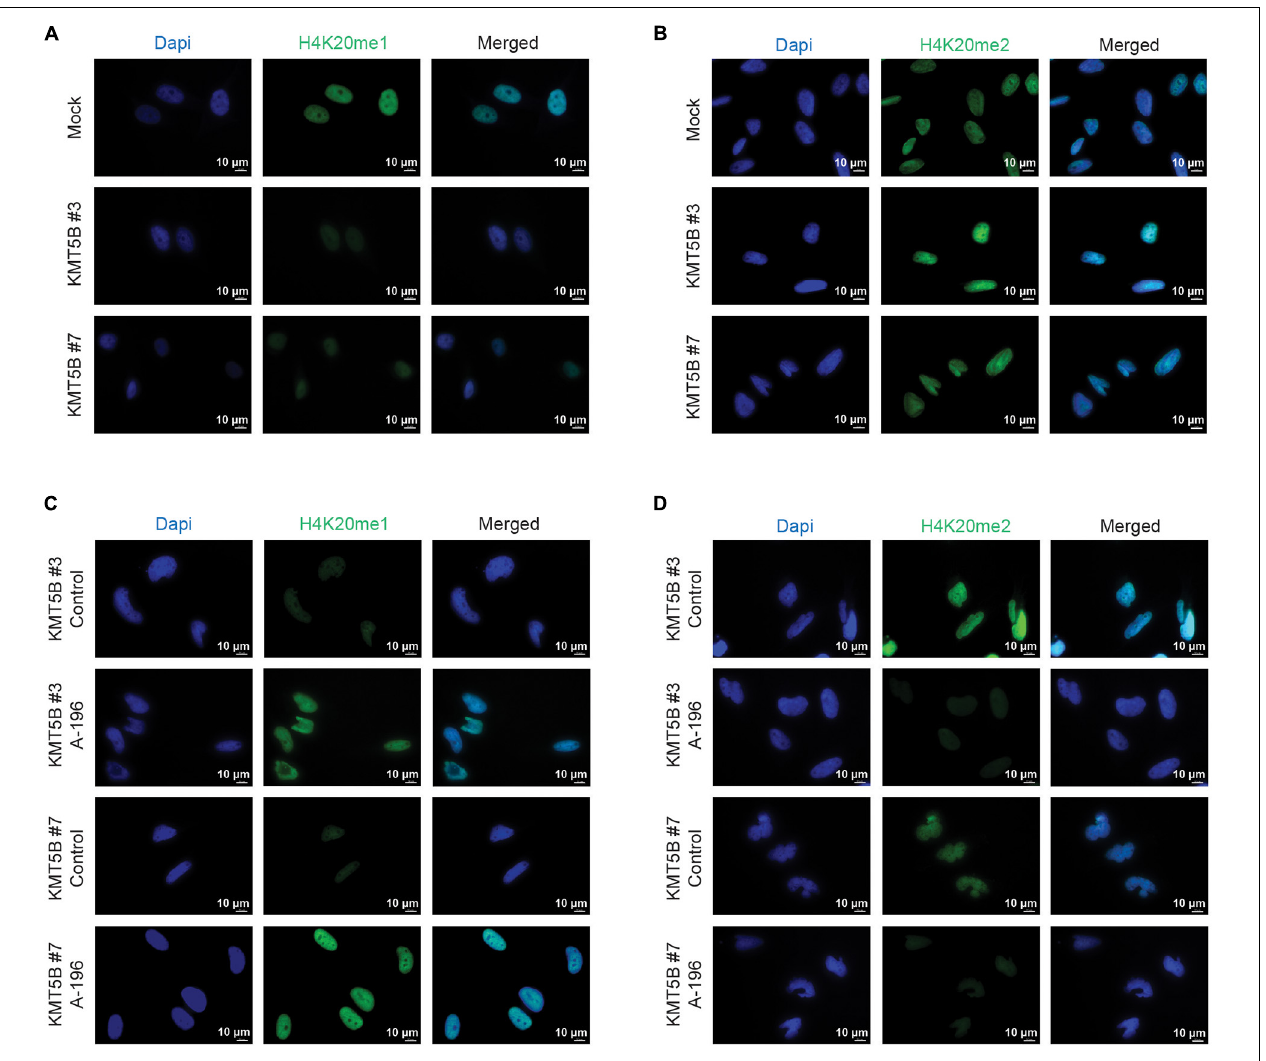
FIGURE 4 | Immunofluorescence analysis of mono- and dimethylation of H4K20. Representative images of mock and KMT5B -transfected clones immunostained with (A) anti-H4K20me1 or (B) anti-H4K20me2 antibodies (green). In panels (C,D) representative images of KMT5B -transfected clones immunostained with (C) anti-H4K20me1 or (D) anti-H4K20me2 antibodies (green) after treating the cells with KMT5B inhibitor A-196 for 48 h. Nuclei were counterstained with DAPI (blue). Bars: 10 µ